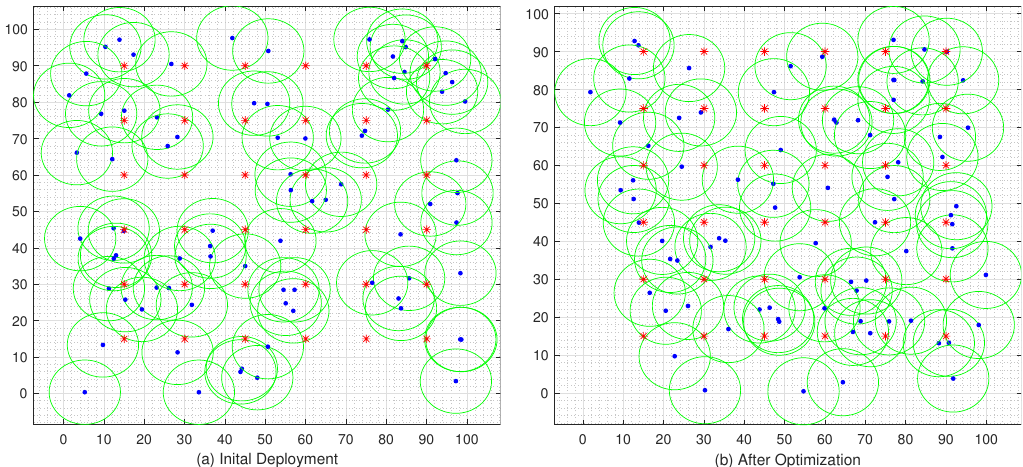
Figure 5. The effect of the improved FPA on the network coverage optimization.